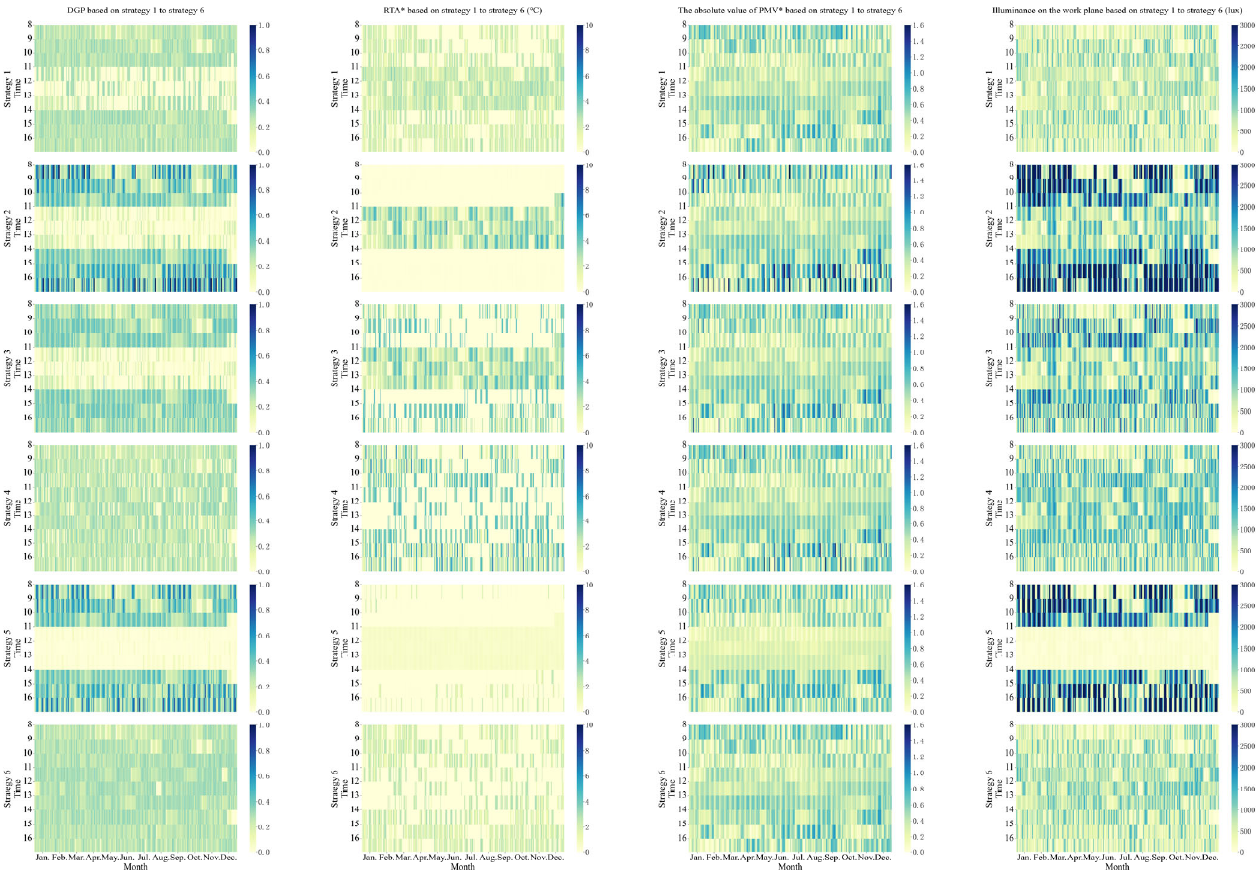
Figure 12. Heat map of annual variation of indices in case 2.